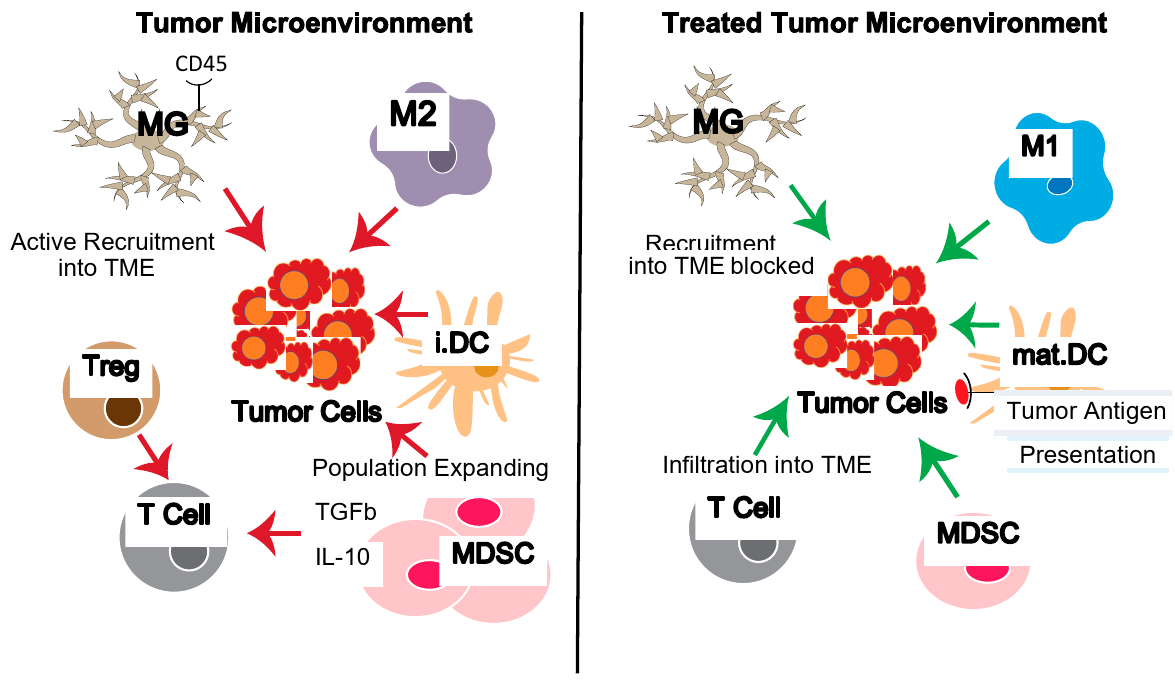
Figure 1. The tumor microenvironment (TME) and reversing TME defects. The tumor microenvi- ronment (TME) contains multiple other cell types which support tumor growth directly (e.g., through growth factors) or indirectly through modulating the local immune response and inhibiting anti-tumor immunity (e.g., tumor-associated macrophages, microglia in the case of GBM, and mye- loid-derived suppressor cells). Effective therapies can target the tumor cells directly and/or the tu- mor-promoting elements of the TME. Pro-tumor element activities are shown with red arrows, nat- ural or therapy-induced anti-tumor functions with green arrows. Left panel : Pro-tumor and domi- nant immuno-suppressive elements of the TME. Right panel : Idealized results of various treatment interventions targeting TME-related defects and reducing immuno-suppressive elements. Abbrevi- ations: GBM, glioblastoma; Macs, macrophages; M1, pro-inflammatory macrophages; M2, anti-in- flammatory macrophages; MDSCs, myeloid-derived suppressor cells; MG, microglia; i.DC, imma- ture Dendritic Cells; mat.DC, mature dendritic cells; TAMS, tumor-associated macrophages; Treg, regulatory T cells; TME, tumor microenvironment. Table 1. Myeloid Cell Populations in GBM and Potential Targets on Each. Refs.